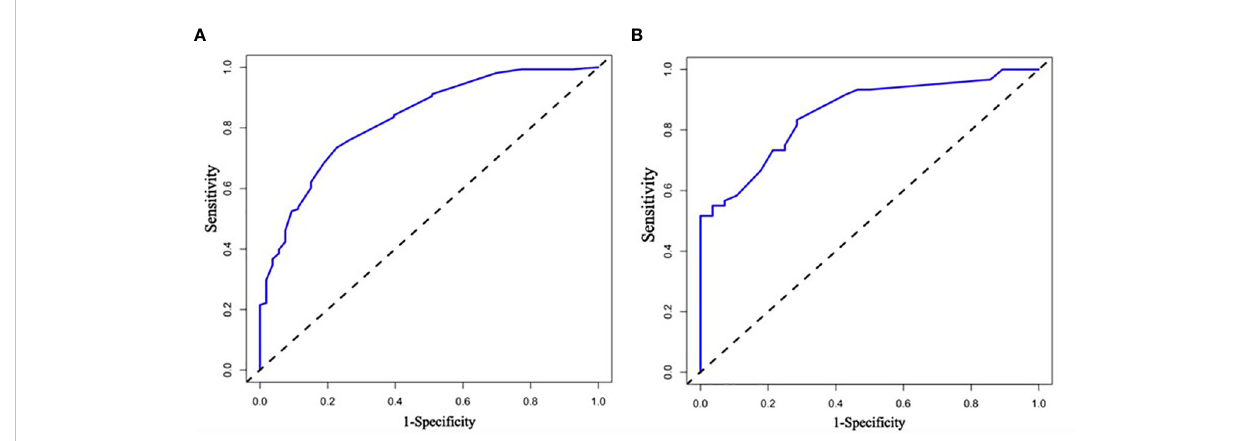
FIGURE 4 (A, B) Are the ROC curves of nomogram of modeling group and veri fi cation group respectively. ROC curve is the subject work characteristic curve; AUC is the effective area under the curve. the calculation of ROC curve is mainly expressed by its AUC area, and different ranges of AUC area represent different